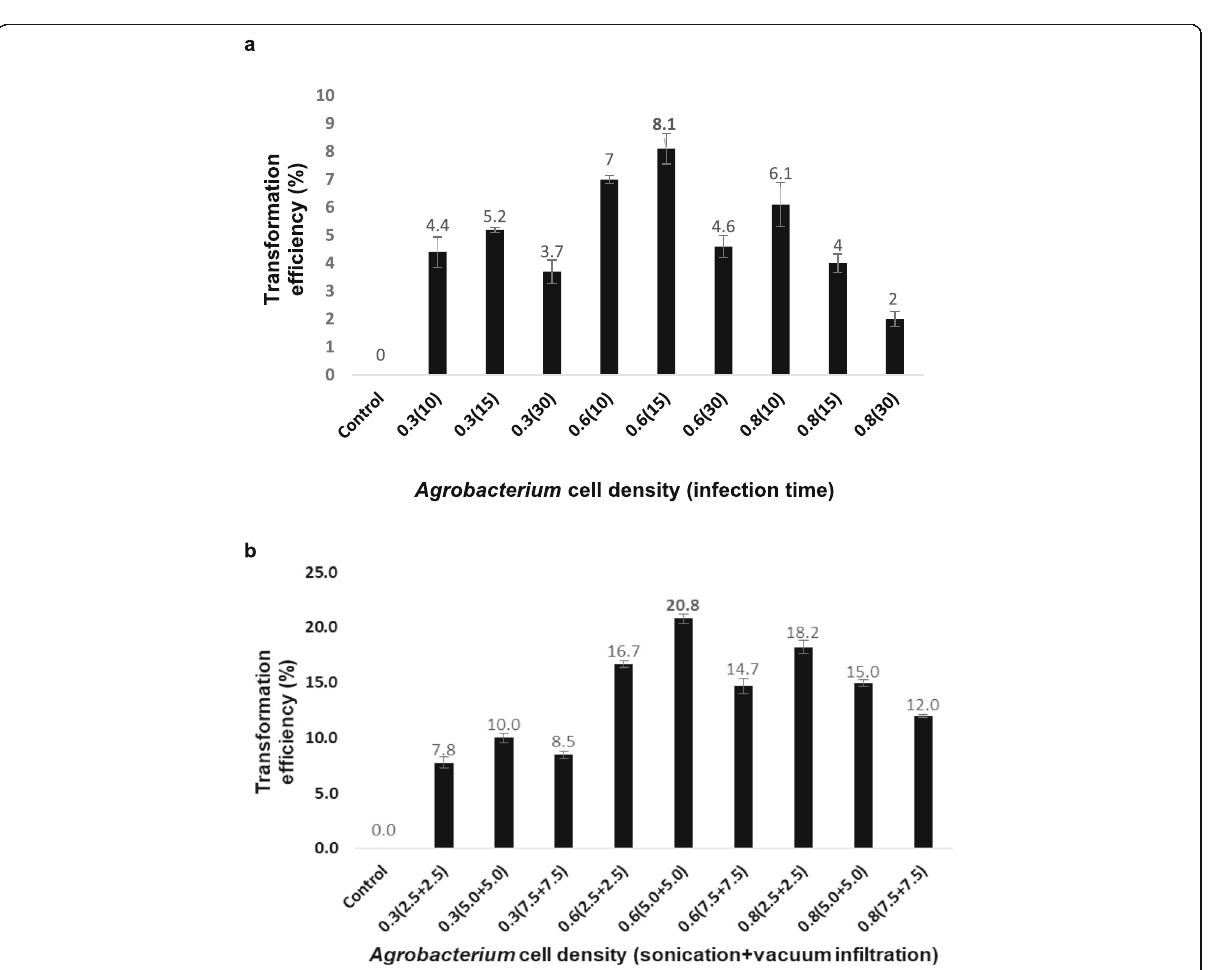
Fig. 4 Effect of Agrobacterium optical cell density, infection period, and sonication combined with vacuum infiltration on influencing the in planta transformation of horse gram. a Effect of Agrobacterium cell density and infection time on transformation efficiency. b Effect of Agrobacterium cell density and sonication combined with vacuum infiltration on influencing the in planta transformation